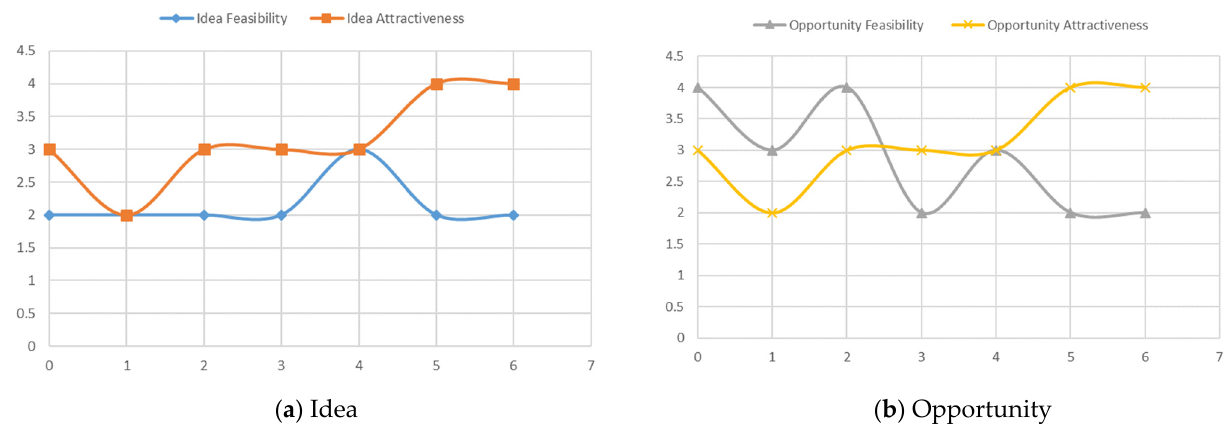
Figure 5. Dynamics of perception of ( a ) idea feasibility and attractiveness and ( b ) opportunity by student A along the entrepreneurial journey on Likert scale 1–5 (min-max). Checkpoints 0–6 correspond to Table 1.